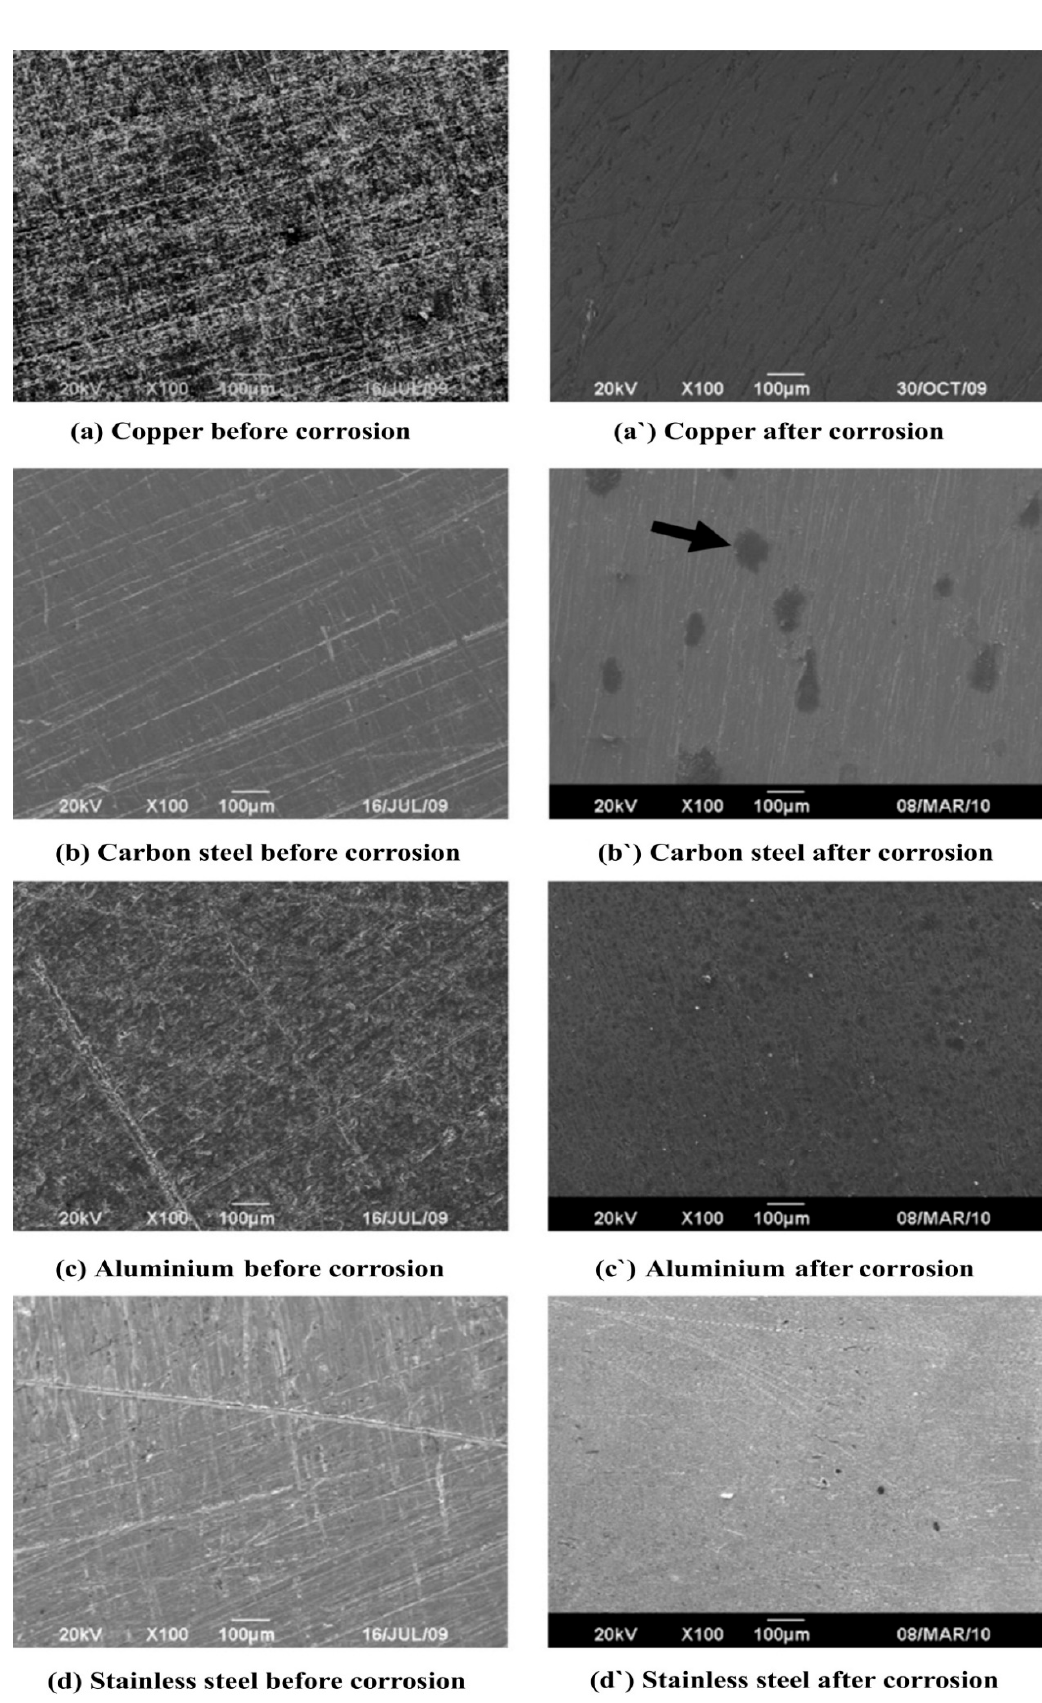
Figure 17. SEM image of the metal surface before and after immersion [71].